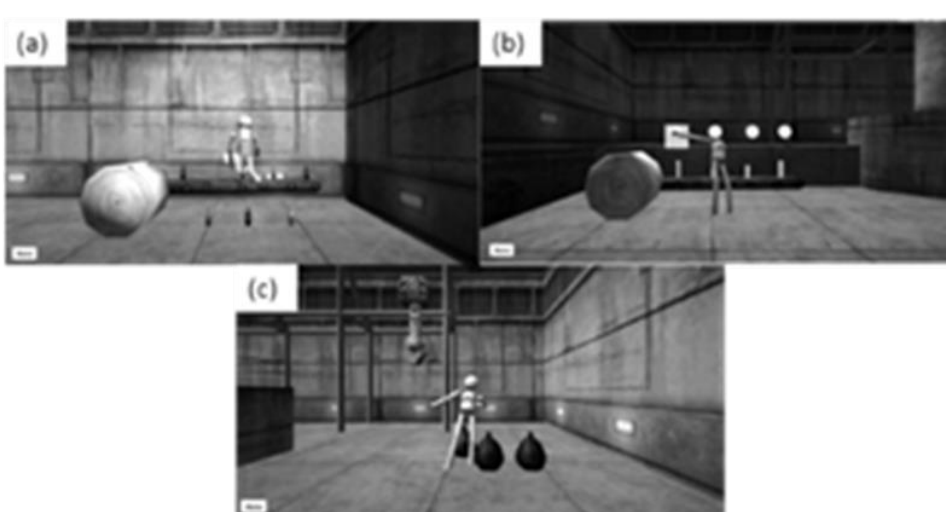
Figure 3a. The bottle-sorting task: The three bottles on the ground indicate to the player where to place the bottles for sorting. Figure 3b. The bottle-filling task: The player holds out a hand “over” the button to “fill up” the bottle. Figure 3c. The bag-loading task: The player “picks up” the bag to place it on the hook in the